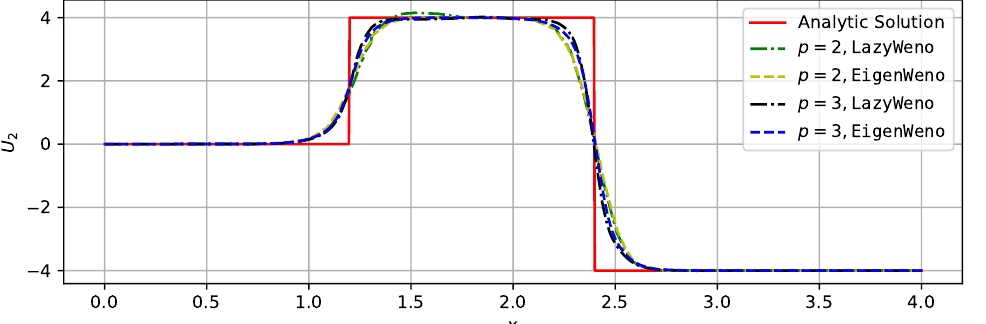
Figure 10. Comparison between solutions of U 2 ( t = 0.3 ) in Problem 2.